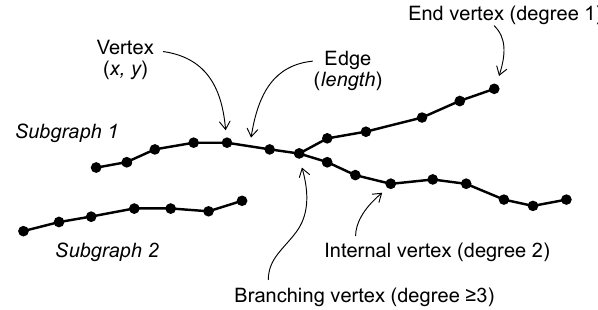
Figure 1. Euclidean graph composed by two disconnected subgraphs. Each vertex is associated with its spatial coordinates in the Euclidean plane. Each edge is associated with a weight propor- tional to the Euclidean distance between its vertices.